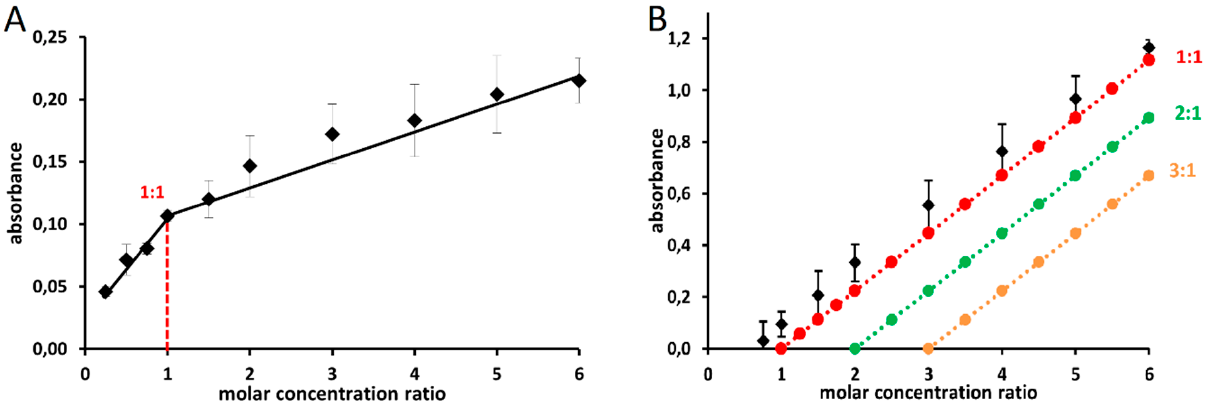
Figure 3. Stoichiometric determination of the complex glaucine:Fe 3+ at pH 7.5 by the Job’s plot ( A ) and the complementary method ( B ). The suggested stoichiometry of the complex was 1:1. Data are from two independent experiments and are depicted as means and standard deviations.